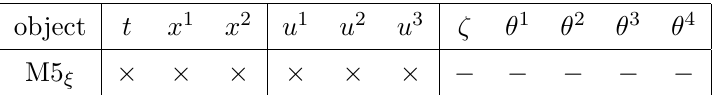
− Table 3 . The M5 ξ or dyonic membrane describing M5 branes with M2 charges dissolved along the hypersurface parametrized by ( u 1 , u 2 , u 3 ) . The transverse space R 5 is parametrized by the coordinates ( ζ, θ 1 , θ 2 , θ 3 , θ 4 ) . The object is 1 2